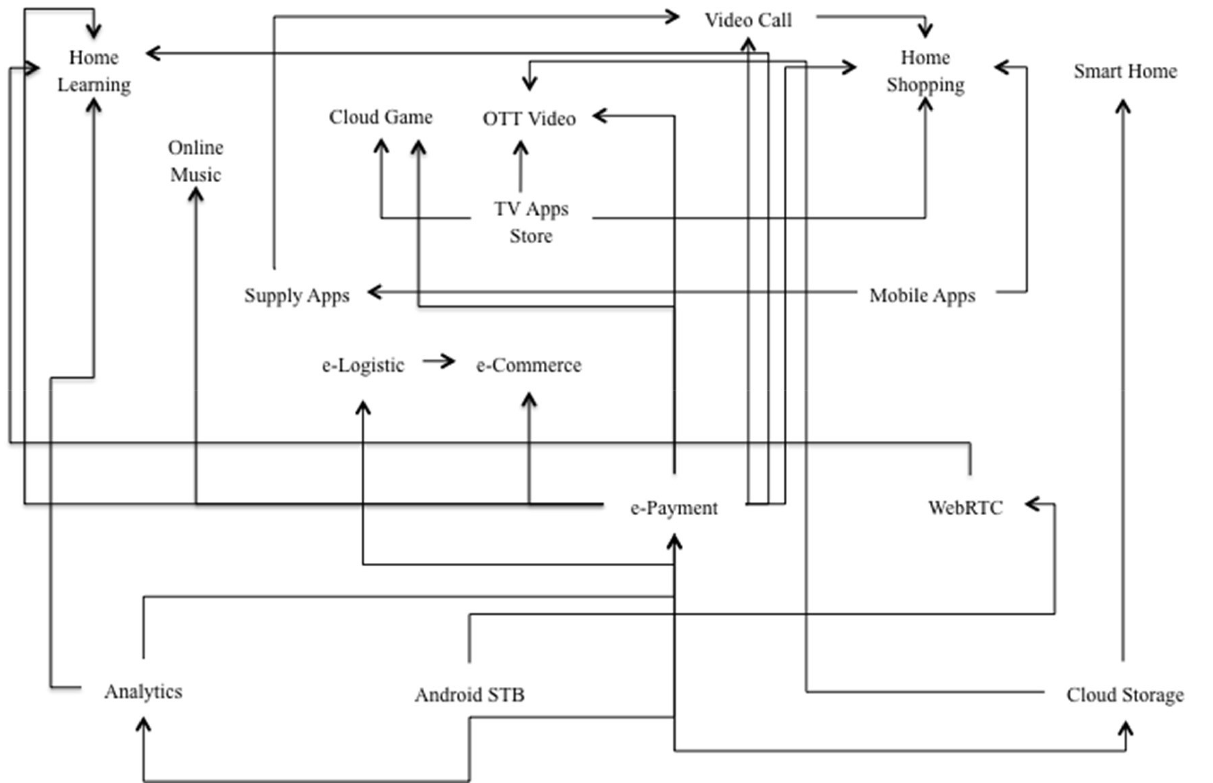
Figure 9. Combination of All Initiatives from Five